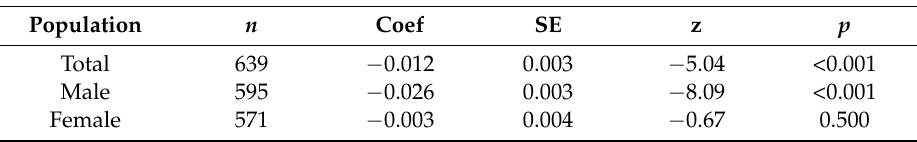
Table A3. Adjusted Poisson log-linear model with daily arsenic dosage ( μ g/day), 1.1 L/day; ≥ 80% dependency, As(Max) ≤ 50, and ND = 1/2 LOD.